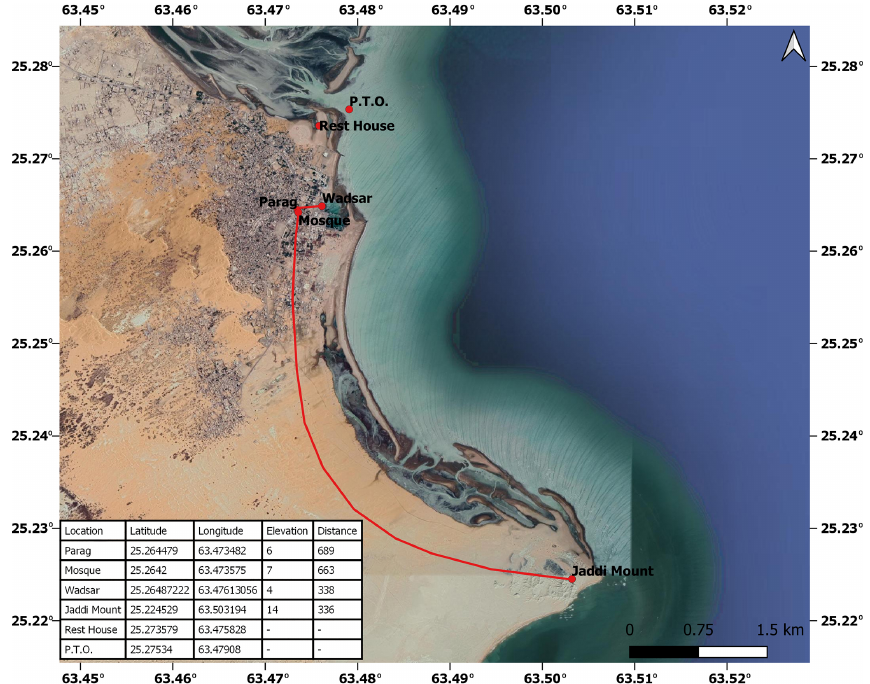
Figure 6. Locations as identified by eyewitness accounts to have been inundated by the 1945 tsunami, plotted on a © Google satellite image. The line shows a crude estimate of inundation extents. The points which have not been joined through the line were identified from newspaper accounts.